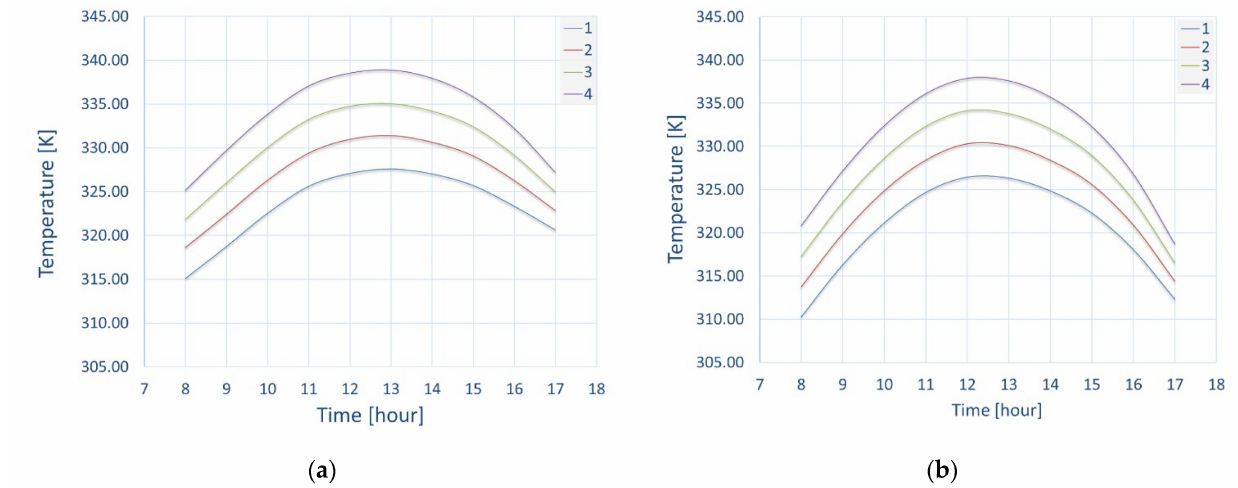
Figure 20. The outlet temperature profiles of the individual collectors (simulation result; 1–4 order of the collector) ( a ) collector with rotation, ( b ) static collector without